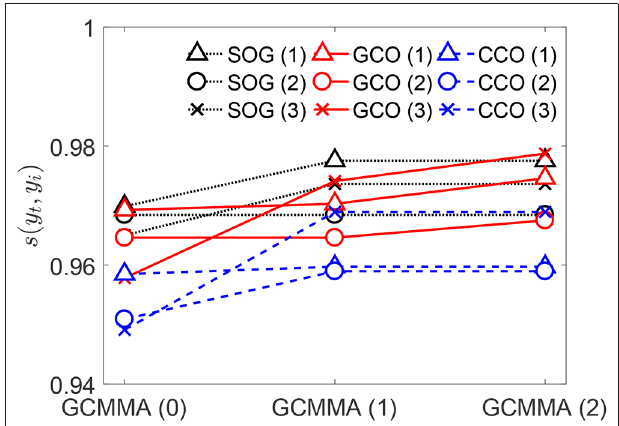
FIGURE 7 | For the outputs of the SOG, GCO, and CCO algorithms, values of the similarity scores with respect to the target curve y t . The threshold pressure p is 0.08 for both the GCO and CCO. ¯ =